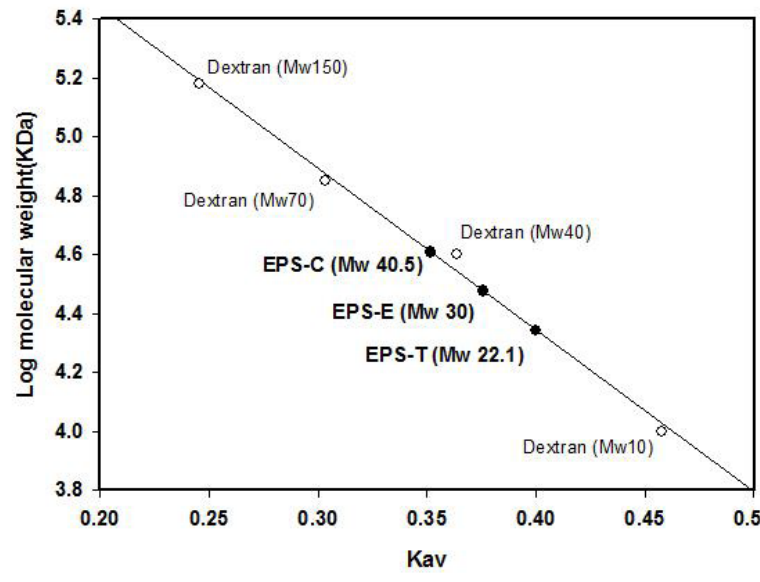
Figure 2. Molecular mass determination of the purified EPSs produced by submerged culture of I. rickii by treatment of Tween 40 (EPS-T) and ethanol (EPS-E), respectively, in Sepharose CL-6B chromatography. Elutes were analyzed by measuring the absorbance at 480 nm for carbohydrate. EPS-C means without addition. Three groups of EPS were denoted as closed